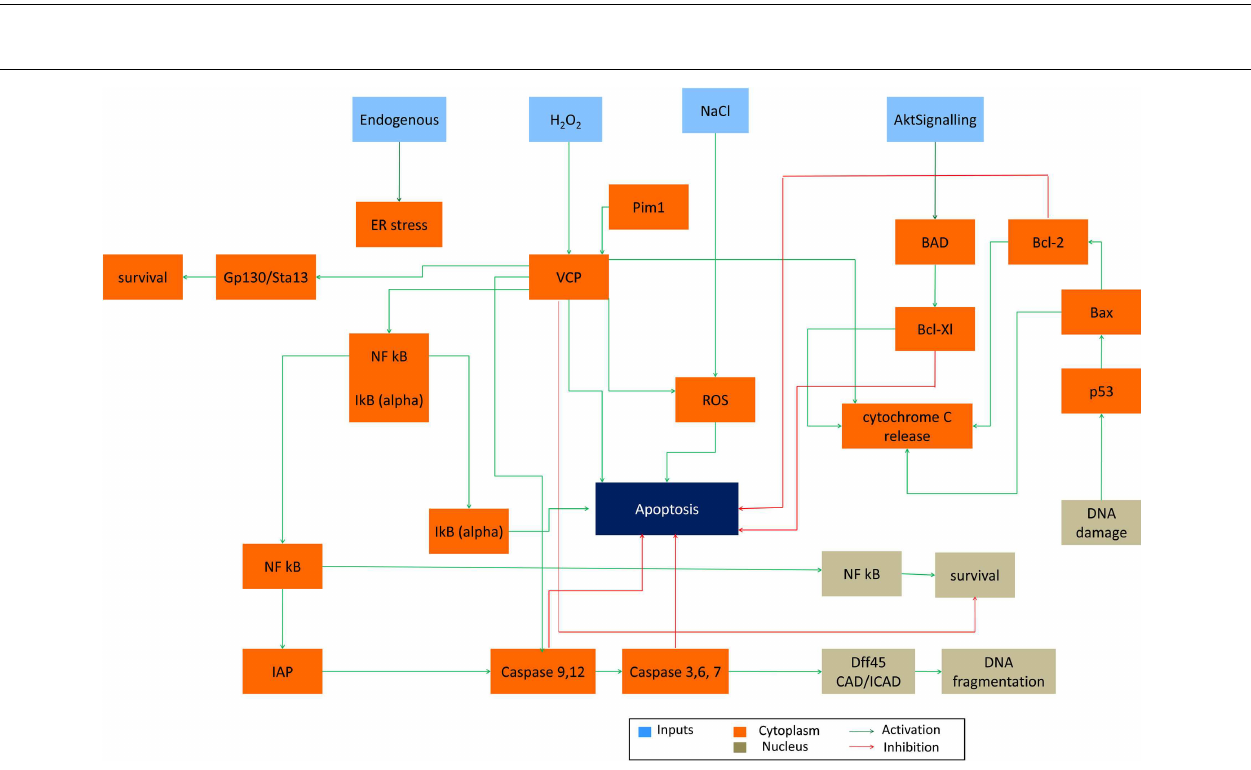
FIGURE 6 | Stm1 study. (A) Presence of Stm1p (blue) promotes apoptosis (yellow; B ) Knock out of Stm1p (blue) prevents apoptosis (yellow) and DNA fragmentation (red) and consequently promotes survival.